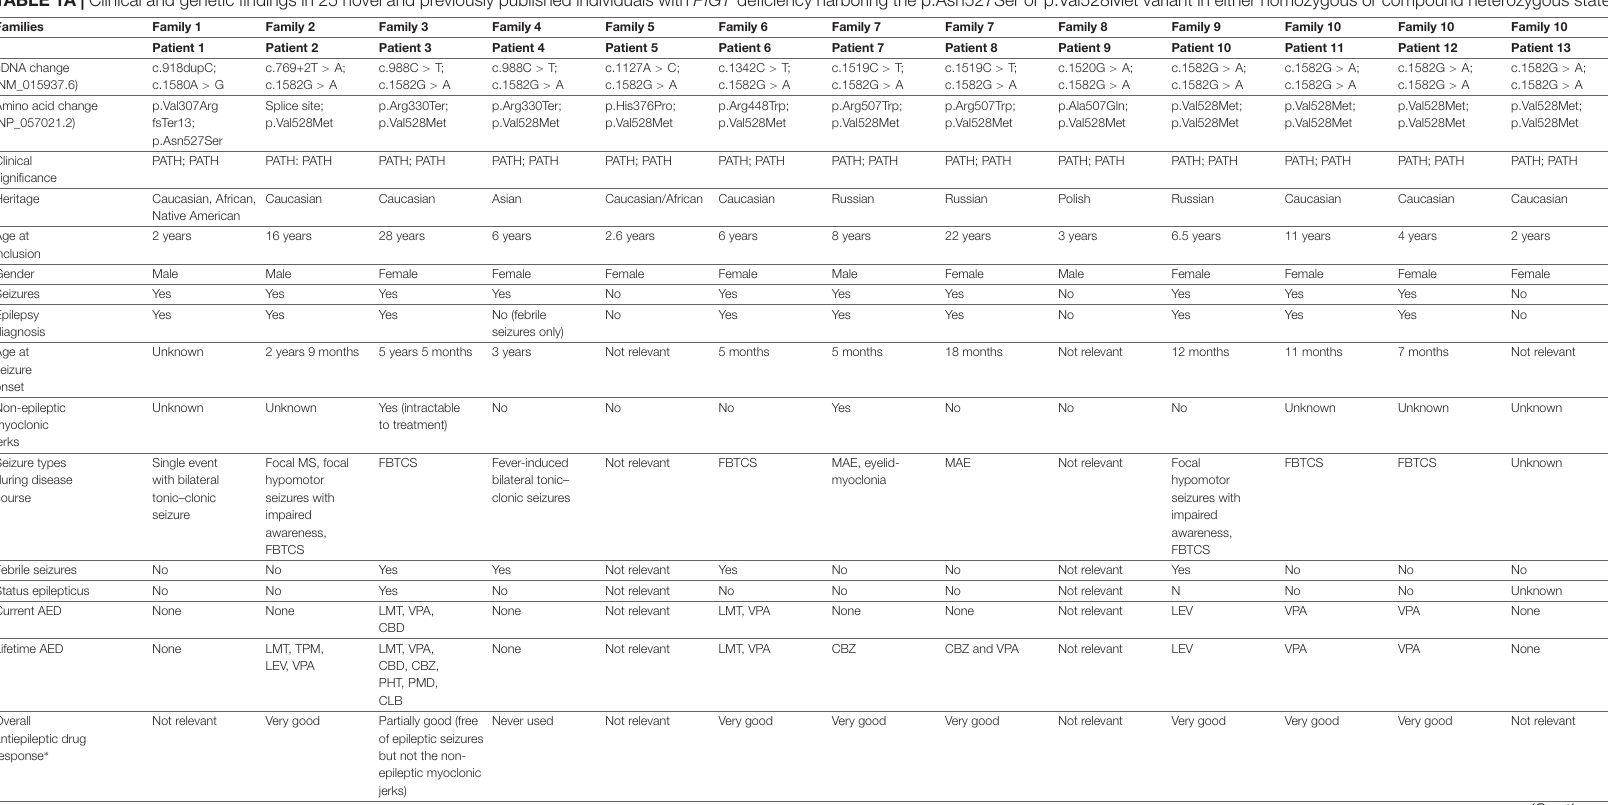
TABLE 1A | Clinical and genetic findings in 25 novel and previously published individuals with PIGT deficiency harboring the p.Asn527Ser or p.Val528Met variant in either homozygous or compound heterozygous state.